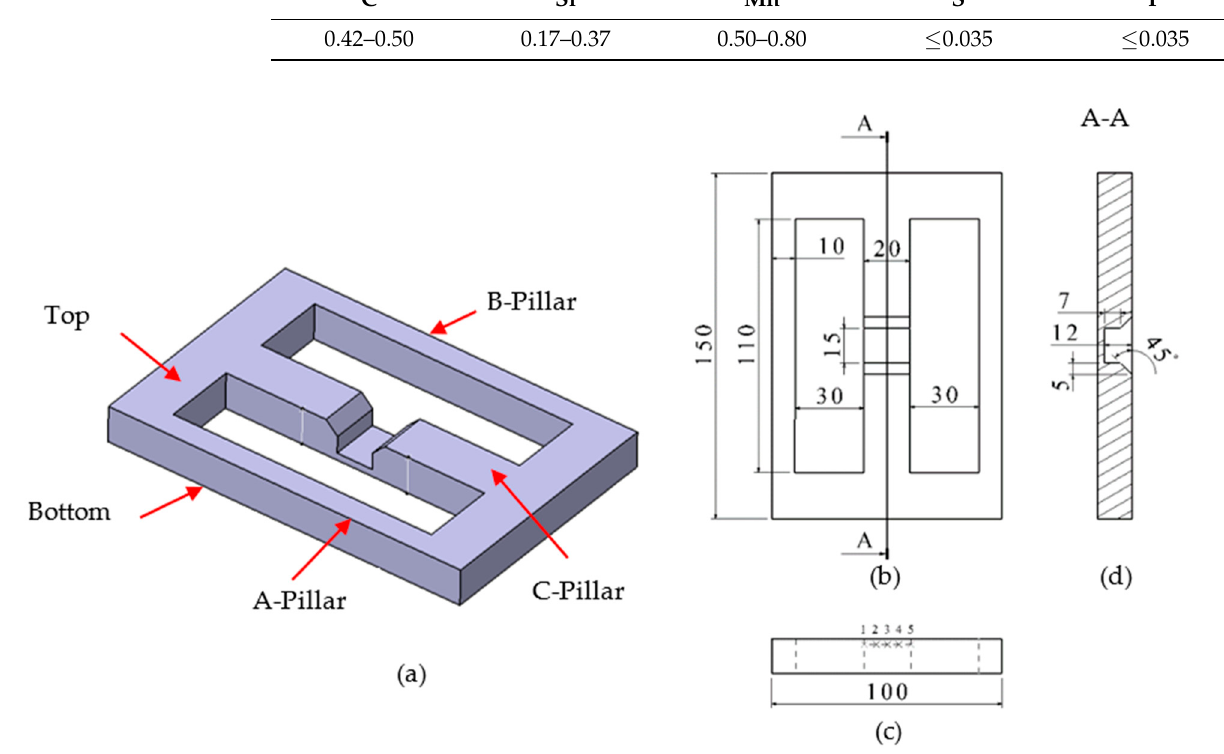
Table 1. Chemical composition of 1045 steel (wt. %).